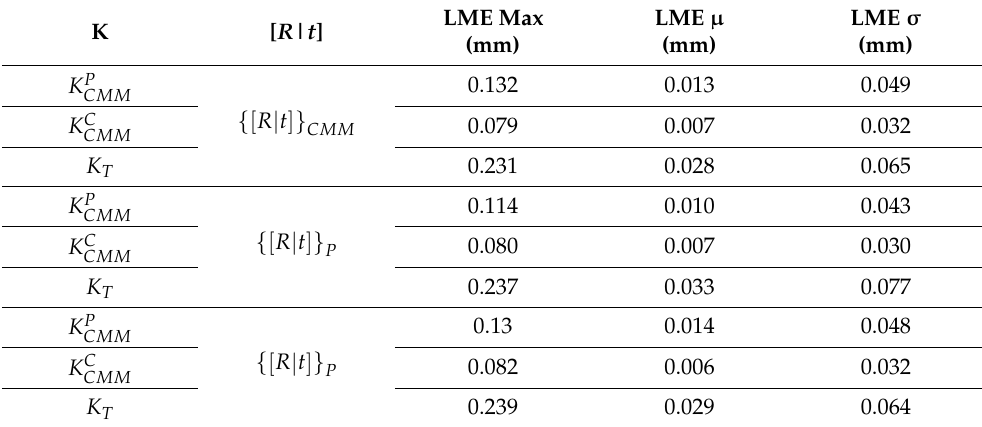
Table 7. LME for the experimental test where the extrinsic calibration geometry is the same for different calibration processes. In addition, a second extrinsic calibration process using portable photogrammetry is included as a repeatability test.